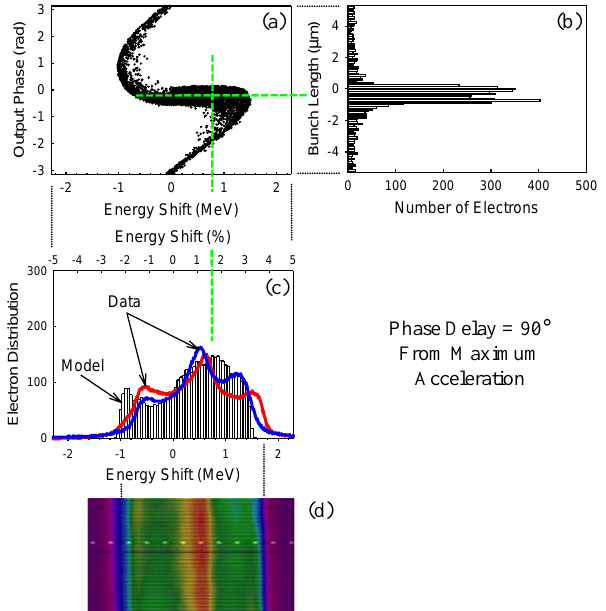
FIG. 4. (Color) Comparison of staging results with model for phase delay 90 ± from Fig. 3. (a) Model-predicted electron output phase versus electron energy, (b) model-predicted electron bunch length, and (c) electron energy spectrum. Two separate data profiles are plotted (red and blue curves). (d) Raw spectrometer output for data plotted in